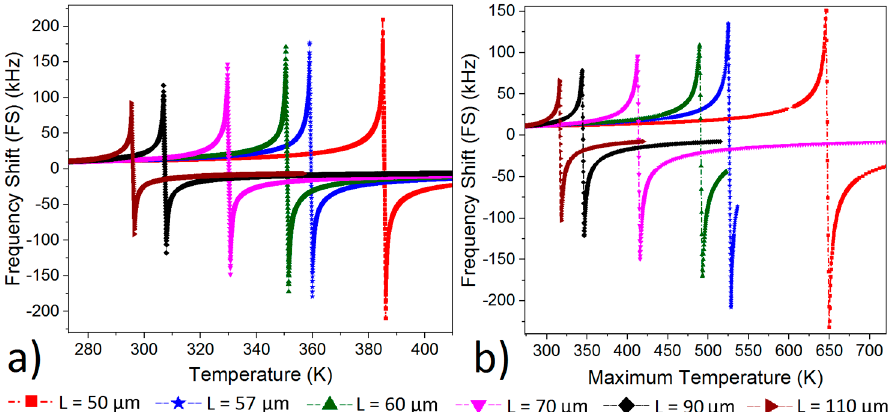
Figure 4. Frequency Shift (FS) with respect to 1 Kelvin (K) change by ( a ) Equation (1), and ( b ) COMSOL, when length ( L ) changes from 50 µm to 110 µm for Device 2 with a device thickness of 1 µm.